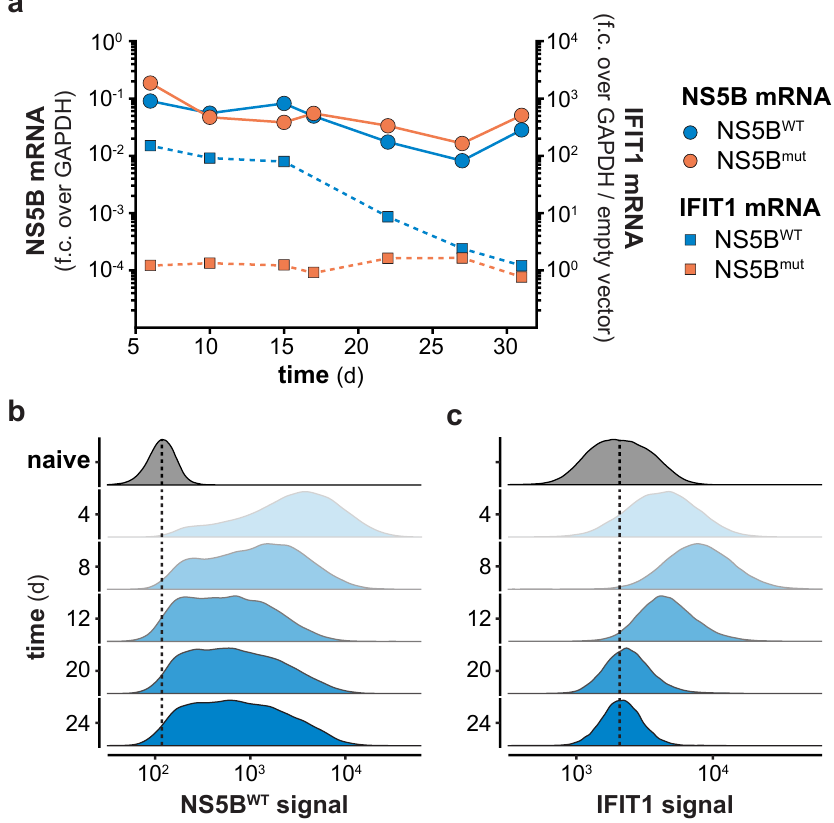
Figure 2. Long term NS5B expression counter-regulates the IFN-stimulated genes (ISG) response. ( a ) NS5B and IFIT1 mRNA levels in A549 cells at the indicated days post NS5B WT or NS5B mut transduction. NS5B fold change (f.c.) over GAPDH or IFIT1 fold change over GAPDH and